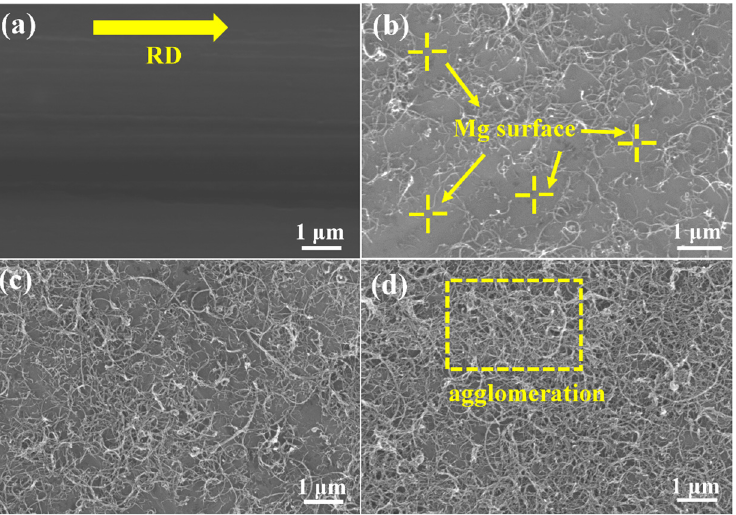
Figure 2. SEM-SE images of Mg foils deposited with distinct mass fraction of CNTs. ( a ) Pure Mg foil; ( b ) 0.15 wt.%; ( c ) 0.50 wt.%; ( d ) 0.70 wt.%.